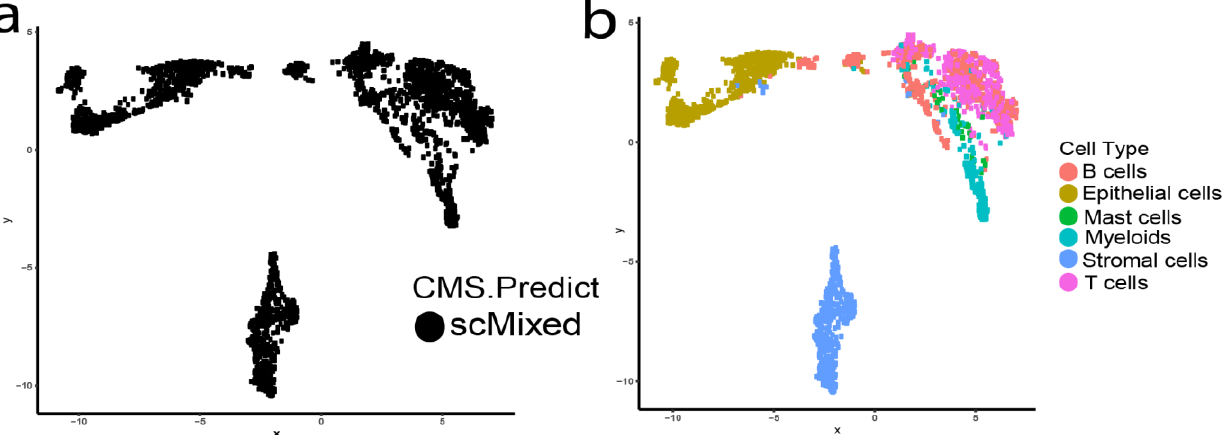
Figure 6: Individual cells with mixed CMS. ( a ) UMAP plot of single tumor cells with mixed transcriptomic states. ( b ) Cell- lineage/cell-type distributions in cells with mixed transcriptomic states. ( c ) Total scCMS-mixed cells within each colorectal- cancer-tissue cell lineage. 3.7. Frequency Distributions of Single Cells CMSs Do Not Correlate with CMS of Matched Bulk Tumor Both bulk and single-cell RNASeq profiles were available for all tumor samples (N = 10) in the discovery dataset [41], which allowed for a comparison of scCMS frequency in scRNASeq profile with the RF probability score for each CMS in bulk RNASeq. We com- puted the cell frequencies of all four scCMSs, scMixed, and unclassified/no-labeled (NOLBL) cells in each scRNASeq profile of all ten tumor samples; and separately calcu- lated posterior probability scores of all four CMSs of each bulk tumor sample using the conventional random forest (RF) classifier of CMS (Table S2) [19]. In the RF classifier of bulk tissue samples, the CMS with the highest posterior probability score (>0.5) was con- sidered the predicted CMS of that tumor sample [19,41]. The predicted CMSs of the bulk tumor samples ( n = 10) were concordant with the CMSs reported in the previous study of the same tumor samples [41]. However, we found that there was not a correlation between the posterior probability from bulk CMS assignment and percentage of cells with given